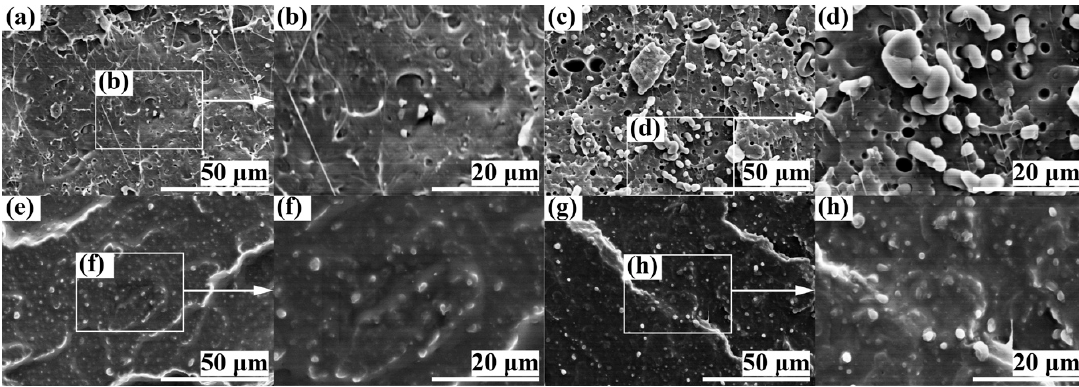
Figure 2. SEM micrographs of the impact-fractured surfaces of PLA / SBS (90 / 10 w / w) blends ( a – d ) uncompatibilized and ( e – h ) compatibilized with 1.0 wt % of S-MA. Images ( a ), ( b ), ( e ), and ( f ) represent the surface topography in the “skin” of a typical injection-molded Charpy notched impact specimen; images ( b ) and ( f ) are magnifications of images ( a ) and ( e ), respectively; images ( c ), ( d ), ( g ), and ( h ) show the surface topography in the “core” of the same specimen; images ( d ) and ( h ) are magnifications of images ( c ) and ( g ), respectively.